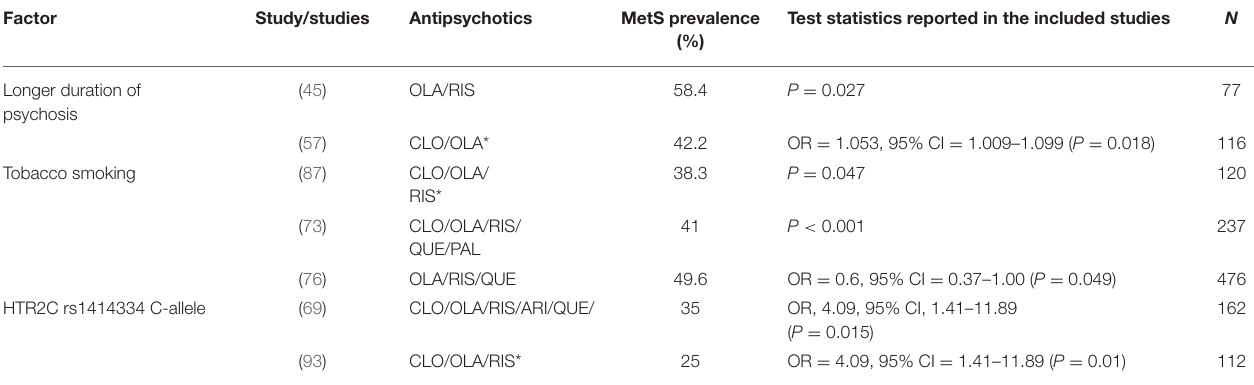
Patients with cumulative exposure to antipsychotics ≤ 2 weeks were categorized as the Minimal Antipsychotic Exposed Group, and the remainder were classified as the Antipsychotic Exposed Group. Moderate risk group. * Also other AP used in this